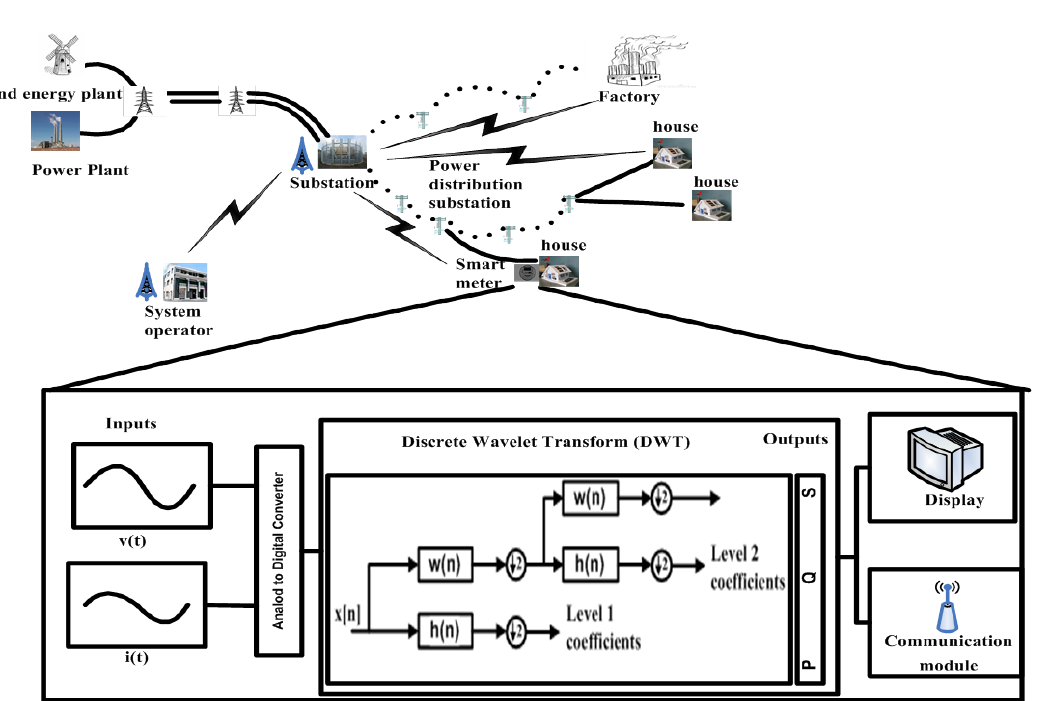
Figure 4. Block diagram of an energy meter using wavelet transform in a smart